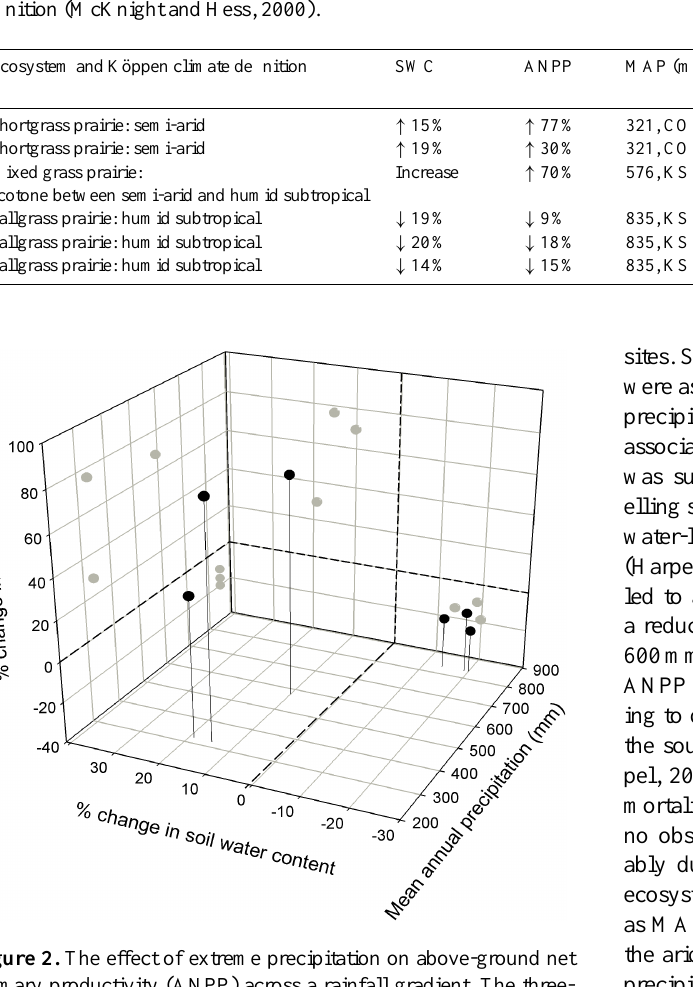
Table 3. Synthesis of extreme precipitation studies on the soil water content (SWC) and above-ground net primary productivity (ANPP), mean annual precipitation (MAP) and mean annual potential evapotranspiration ( E pot ) of grasslands, showing that ANPP either increases or decreases in the same direction as SWC. CO stands for Colorado, KS stands for Kansas. Ecosystem is defined using the Köppen climate definition (McKnight and Hess, 2000).